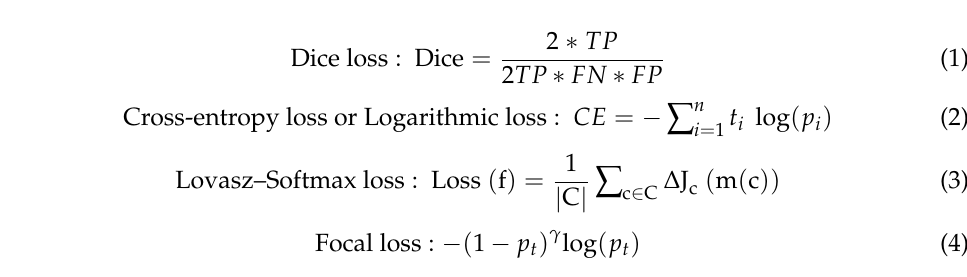
Table 2. The percentage of pixels for each facies class in the training dataset of A Field.